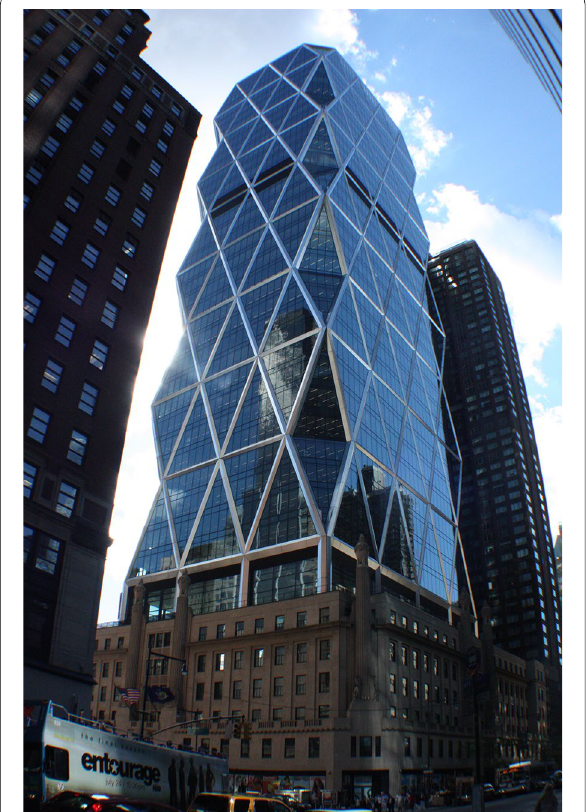
Fig. 22 The Trump Tower in Chicago reflects the clouds, the sun, and the surrounding buildings on its curtain wall